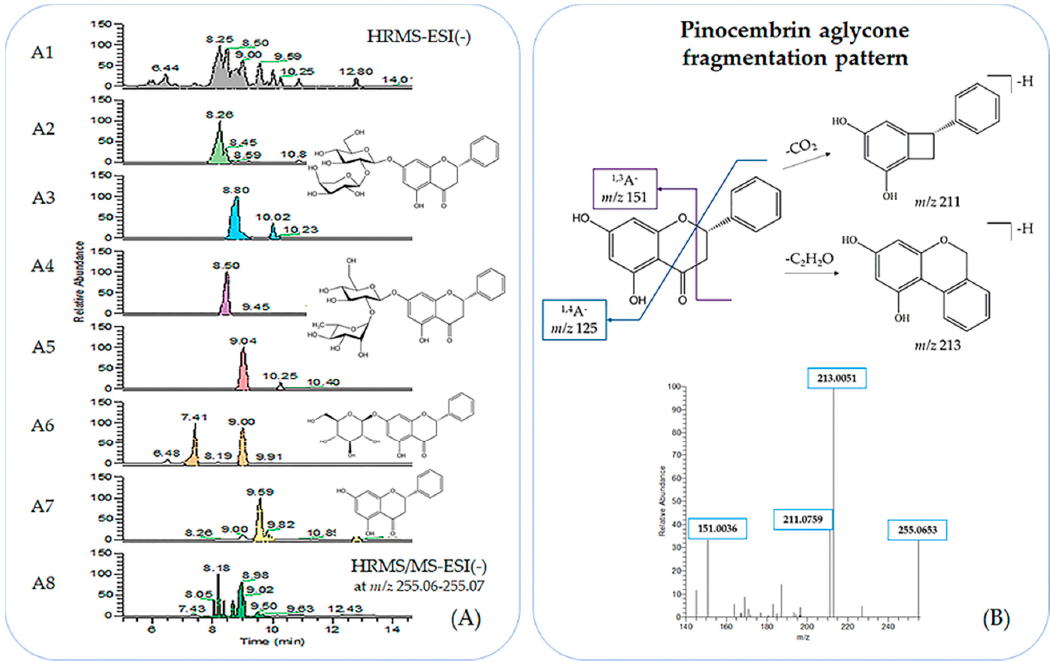
Figure 3. ( A ) A1: UPLC-ESI( − )-HRMS profile of Centaurea raphanina enriched decoction;